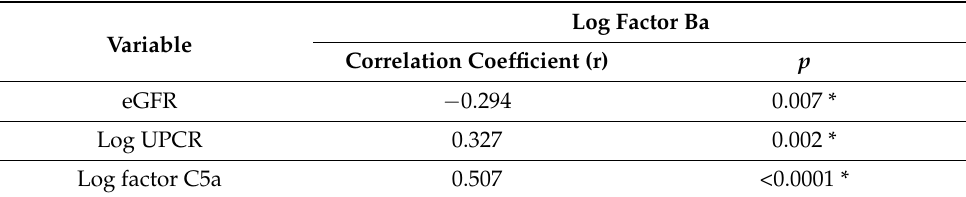
Table A2. Correlation analysis of the plasma factor Ba level with clinical parameters and plasma factor C5a level.